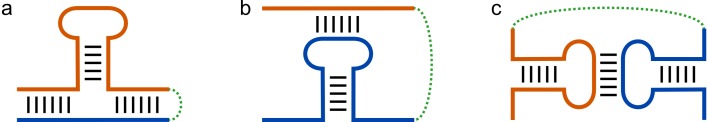
RNA–RNA interaction examples.(a) an interaction pattern that can be predicted by cofolding algorithms but not using standard accessibility-based methods, and a (b) kissing stem–loop or (c) kissing hairpin interaction pattern, both cannot be predicted by cofolding but using accessibility-based approaches. The RNA molecules are depicted in orange and blue, while the linker is indicated in dotted green. Base pairs are illustrated in black.